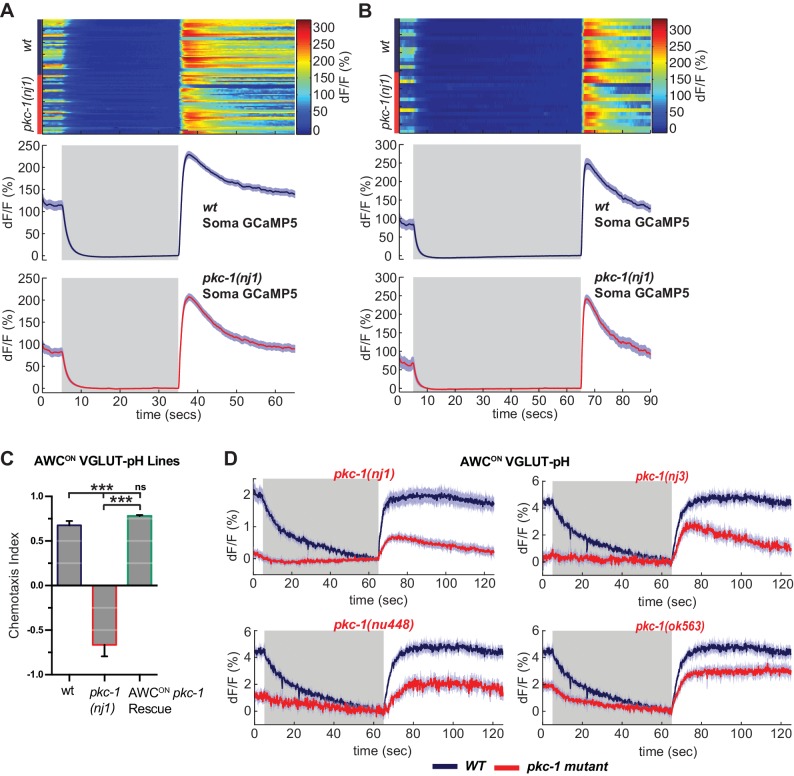
pkc-1(lf) alters synaptic release downstream of calcium influx.(A,B) AWCON GCaMP5 responses to 30 s (A) and 60 s (B) pulses of butanone, measured at the soma. Top panels: Heat map of individual trials. Bottom: average across trials. (A) pkc-1(nj1) n = 50 (17 animals, 2–3 trials each), wt n = 47 (16 animals, 2–3 trials each). (B) pkc-1(nj1) n = 16 (16 animals), wt n = 16 (16 animals), one trial each. (C) Butanone chemotaxis index (see Materials and methods) of AWCON VGLUT-pH transgenics used in Figure 8D, showing that expression of pkc-1 cDNA in AWCON under the str-2 promoter rescues pkc-1(nj1) chemotaxis. n = 3 population assays per genotype. One-way ANOVA, ***p<0.0001. ns = not significant. Error bars = S.E.M. (D) VGLUT-pH responses in pkc-1 mutant alleles. nj1 and nu488 disrupt the kinase domain, nj3 terminates the protein before the kinase domain, and ok563 disrupts two of three isoforms (see Supplementary file 2). pkc-1(nj1) data are from Figure 8B. pkc-1(nu448) n = 10 (4 animals, 2–3 trials each), pkc-1(nj3) n = 18 (6 animals, three trials each), pkc-1(ok563) n = 48 (16 animals, three trials each), wt n = 36 (12 animals, three trials each). Alleles nu488, nj3 and ok563 are plotted with the mean response of pooled wild-type controls from those experiments. Gray areas mark stimulus periods, 11.2 µM butanone. Shading = S.E.M.